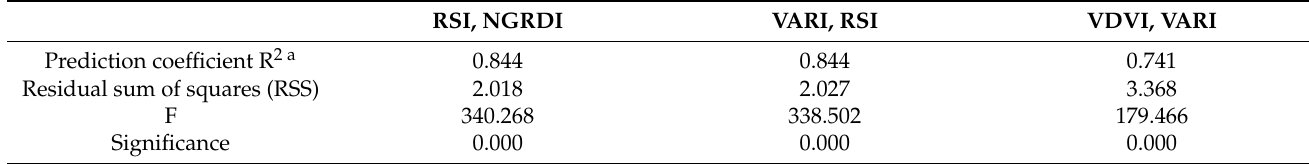
Table 5. Comparison of model parameters of three sets of parameter combinations.